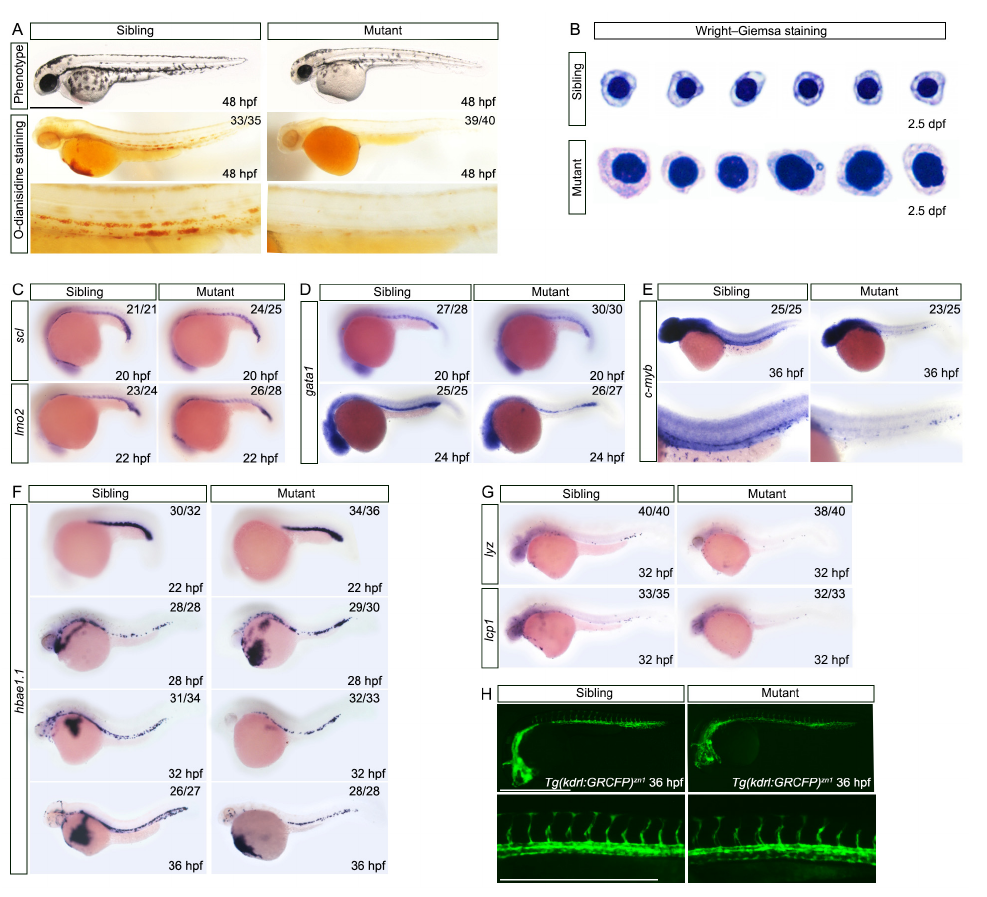
Figure 3. Nop56 deficiency impairs erythroid maturation. ( A ) o-Dianisidine staining showed deple- tion of erythroid cells in nop56 − / − embryos compared to wildtype siblings at 48 hpf. ( B ) Wright– Giemsa staining of erythroid cells at 2.5 dpf in siblings and mutants. ( C ) WISH showed that the expression patterns of scl and lmo2 were indistinguishable between siblings and mutants before 24 hpf. ( D ) WISH showed no difference in gata1 expression in nop56 − / − embryos at 20 hpf between sib- lings and mutants, but a minor reduction occurred at 24 hpf in mutants. ( E ) WISH revealed that c- myb expression was significantly reduced from 36 hpf. ( F ) Expression of hbae1.1 was gradually de- creased from 32 to 36 hpf ( n = 3). ( G ) WISH showed that the number of myeloid cells marked with lyz and lcp1 was slightly decreased at 32 hpf. ( H ) Analysis of vasculature after crossing nop56 mu- tants with the Tg(kdrl:GRCFP) zn1 transgenic fish line. The vasculature development was normal in mutants. All scale bars represent 500 µm.